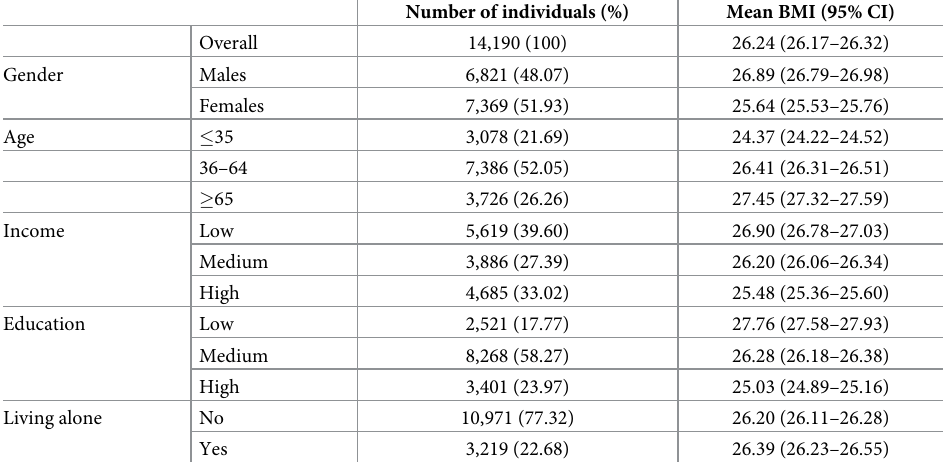
Table 1. Mean Body Mass Index (BMI) and (95% confidence interval) in Kg/m2 reported separately by gender, age, income, education, and living